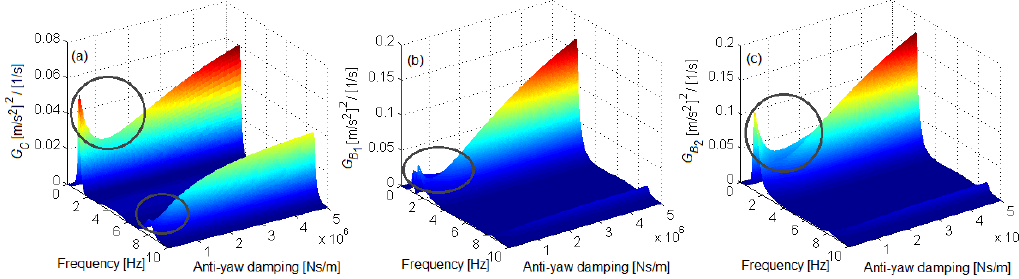
Figure 7. Influence of the anti-yaw damper stiffness upon the power spectral density of the carbody acceleration: ( a ) at the carbody center; ( b ) against the front bogie; ( c ) against the rear bogie.